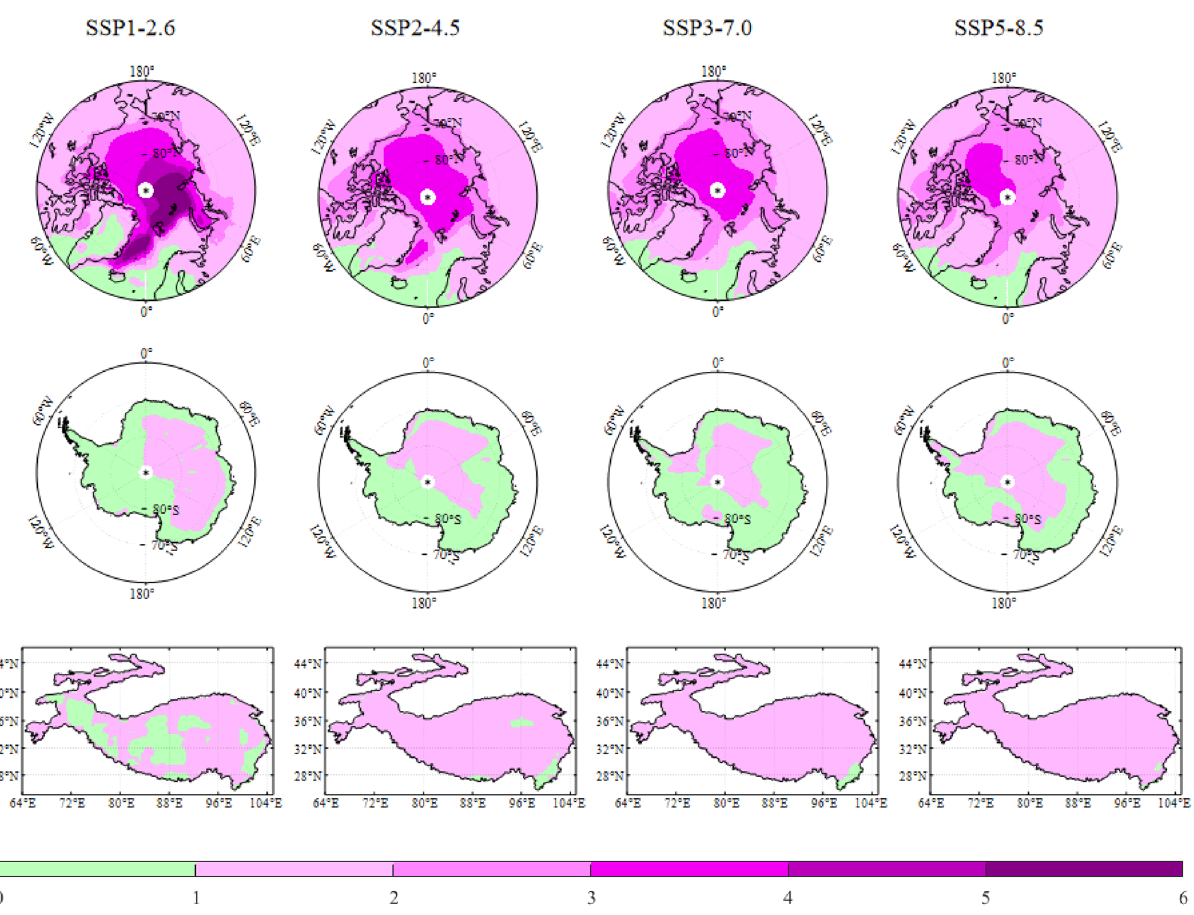
Figure 9. Similar to Fig. 5, but for the Polar amplification Index (PAI1) during 2015–2100. The map was drawn in the software MATLAB R2018b (https:// ww2. mathw orks. cn/ produ cts/ matlab.